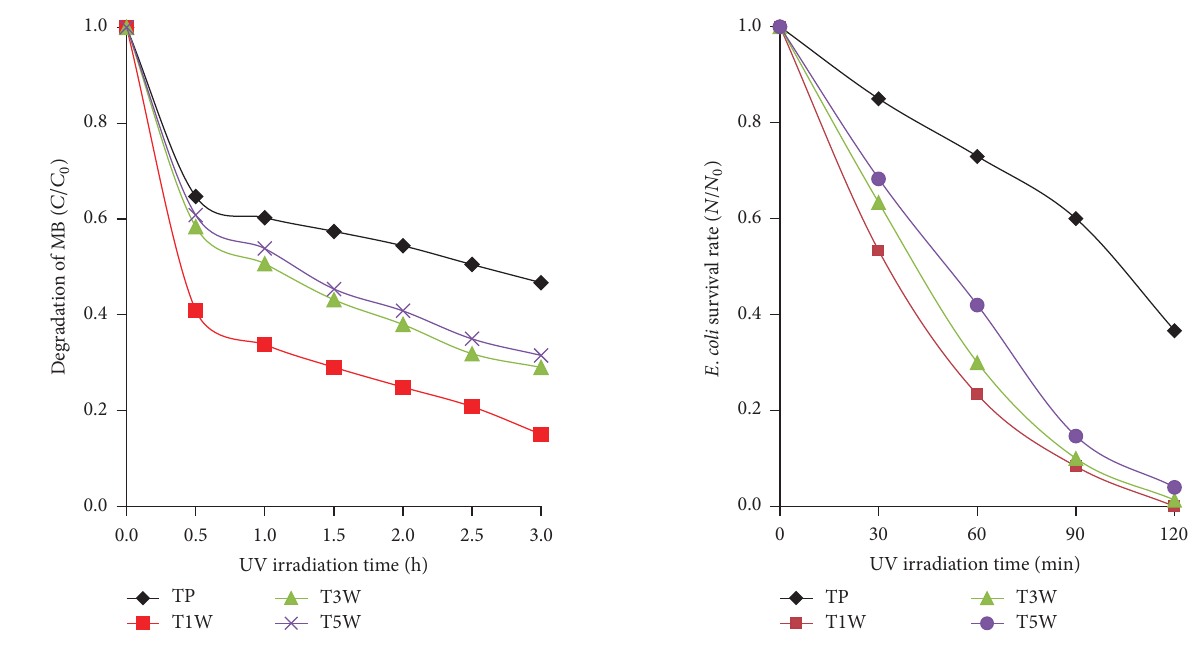
Figure 4: The photocatalytic activity of WO 3 -doped TiO 2 coated CA on degradation of MB.